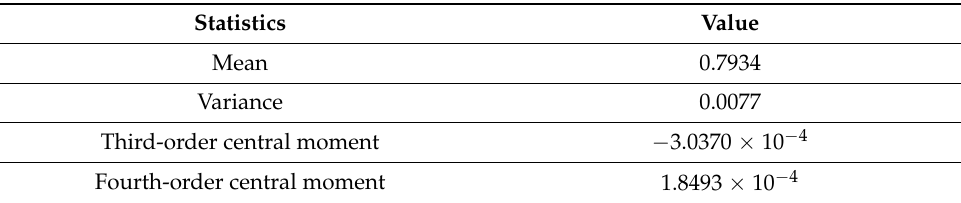
Table 5. Statistics of health index.